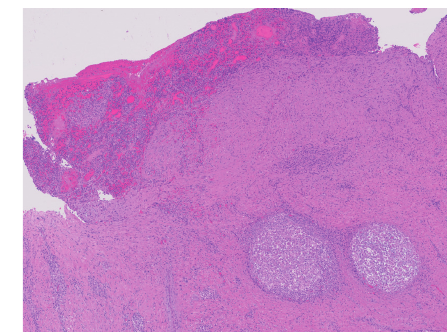
Figure 1: Histopathology of the supraclavicular ganglion exeresis (case 1). Nodular granulomatosis with extensive necrosis replacing the normal tissue architecture (haematoxilina-eosina, magnified ×